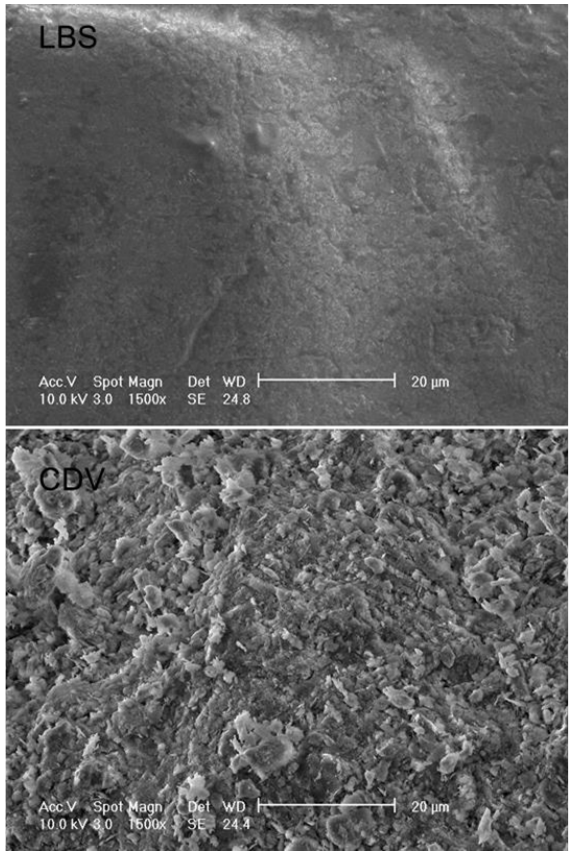
Figure 2. Close image from scanning electron microscope of LBS grain ( top ) and CDV granule ( bottom ) indicating their surface characteristics.